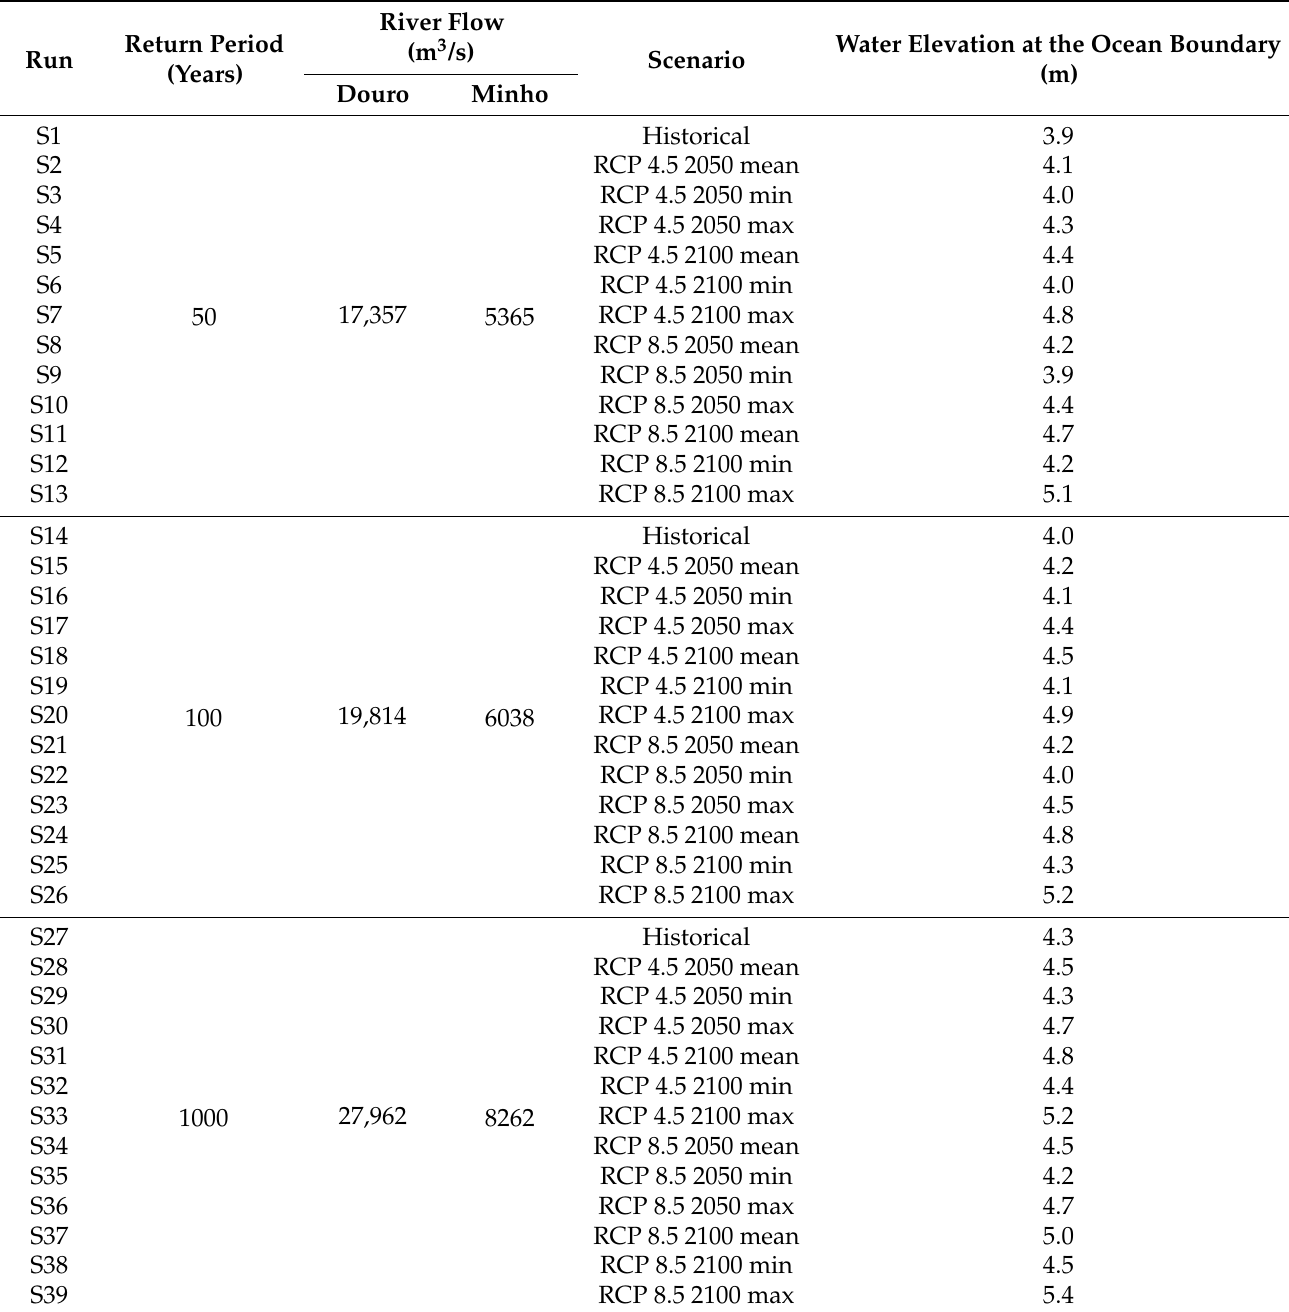
Table 1. Numerical modeling